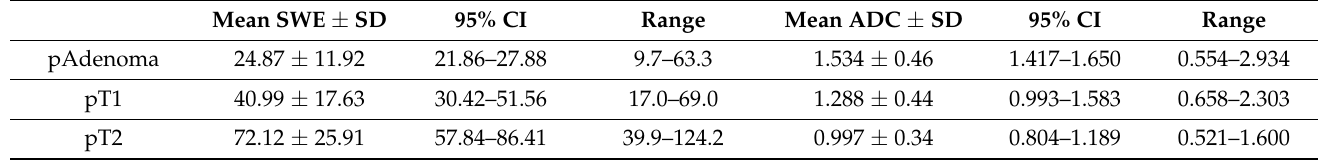
Table 3. Mean values of shear-wave elastography (kilopascal) and apparent diffusion coefficient (10 − 3 mm 2 /s) of pAdenomas, pT1, and pT2 adenocarcinomas.